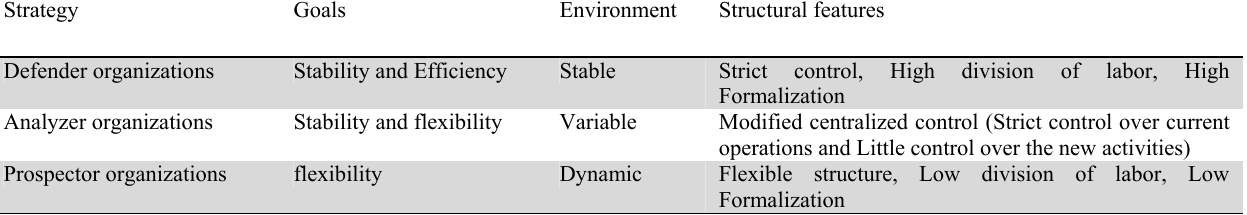
The relationship between structure and strategy based on the study by Miles and Snow (Robbins, 1990) Strategy